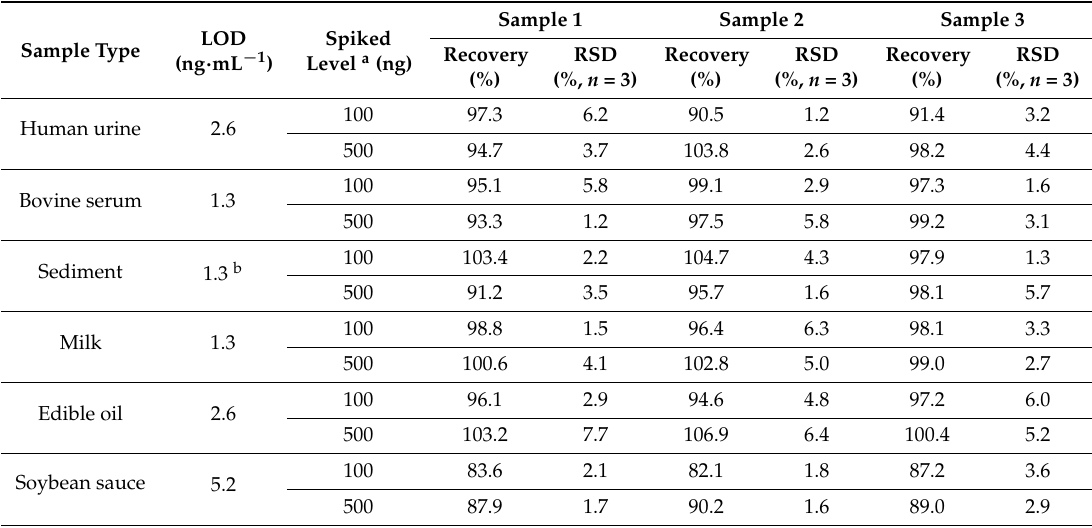
Table 2. Limits of detection (LODs), average recoveries, and relative standard deviations (RSDs, n = 3) of BPA obtained after the PPMIP-SPE of human urine, bovine serum, sediment, milk, edible oil, and soybean sauce samples at two different spiking levels.